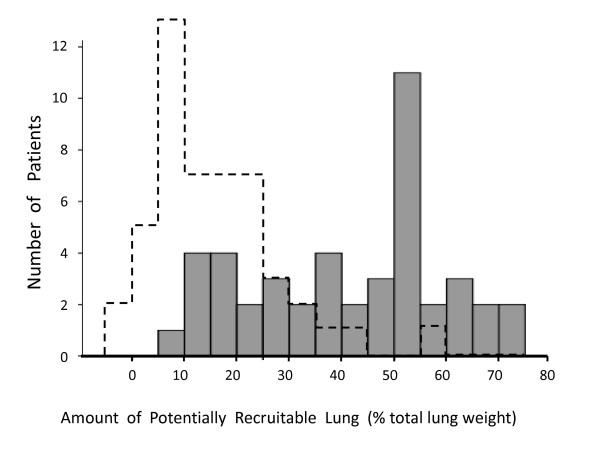
Histogram for the amount of potentially recruitable lung observed in our sample of patients (N = 45). Dashed lines represent the equivalent histogram described by Gattinoni and cols. in a previous publication [29].